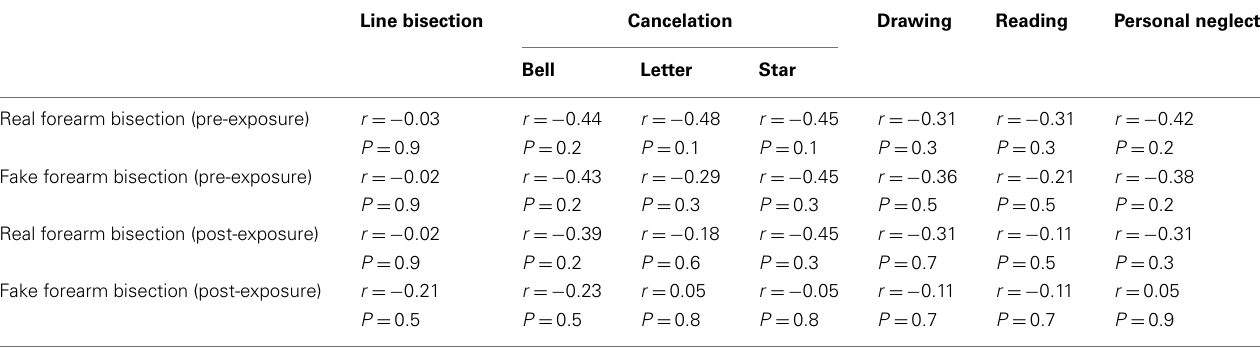
Table 4 | Correlation matrix between the bisection performances of RHD patients in the real and the fake forearm conditions, pre- and post-PA, and neuropsychological